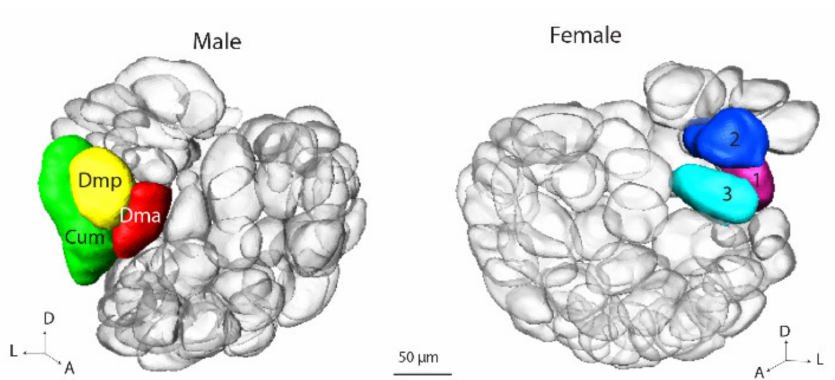
Figure 3. Three-dimensional reconstruction of the male macroglomerular complex (MGC) and the female complex (Fx). The MGC includes three units: the cumulus (Cum), the dorsomedial posterior (Dmp) and dorsomedial anterior (Dma) glomeruli. The Fx includes three enlarged glomeruli, having a similar location with the MGC.